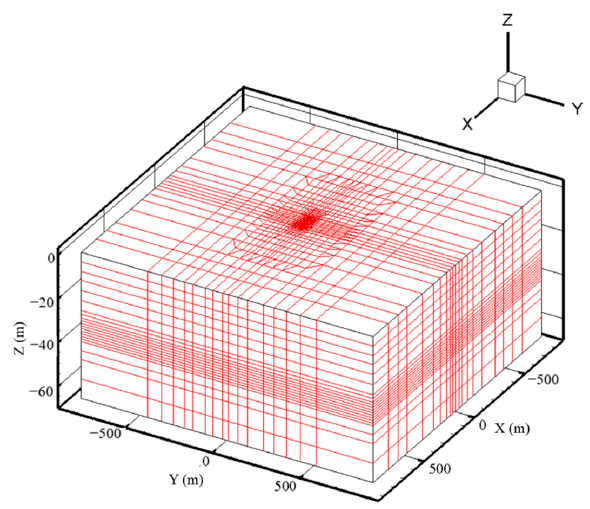
Figure 4. Three-dimensional model domain and the grid mesh.